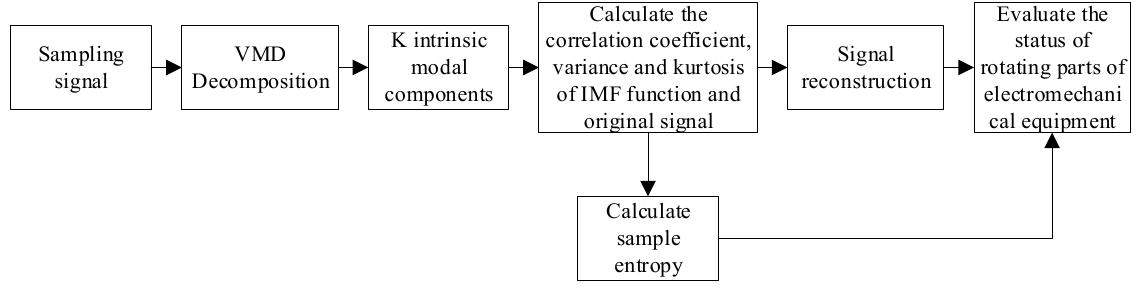
Figure 5. Flow chart of feature extraction.